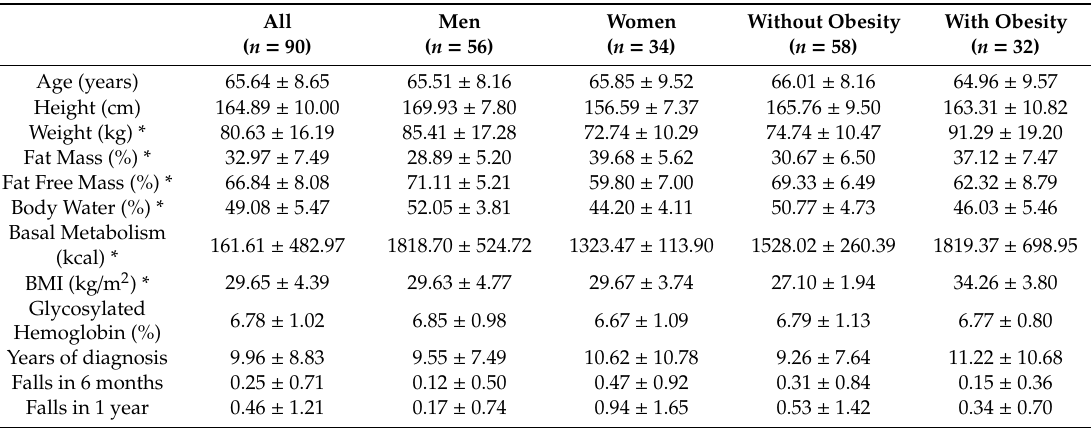
Table 1. Baseline characteristics of the study